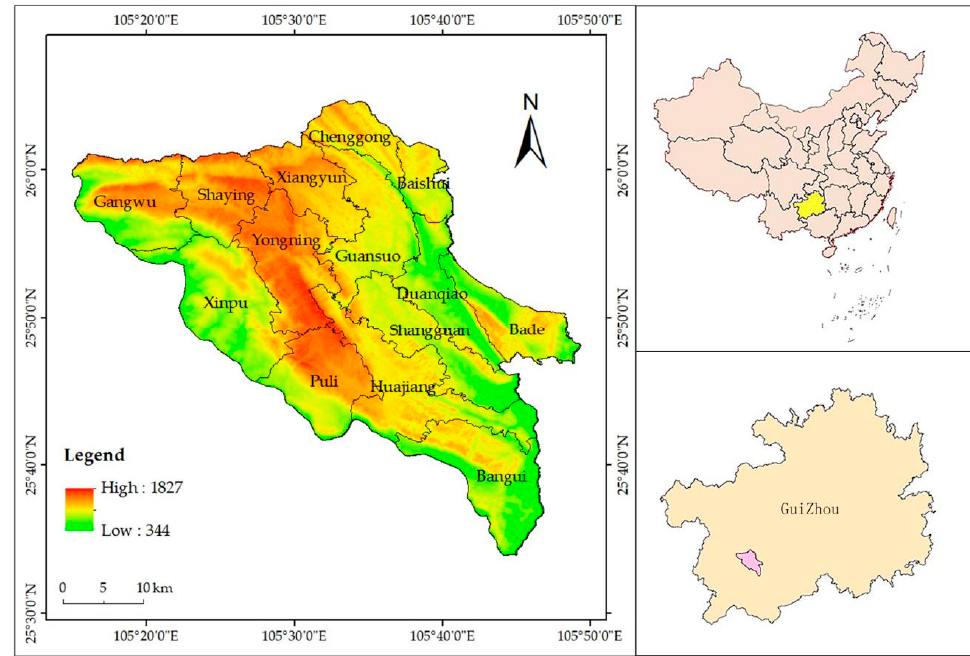
Figure 1. Geographical location map of Guanling County.